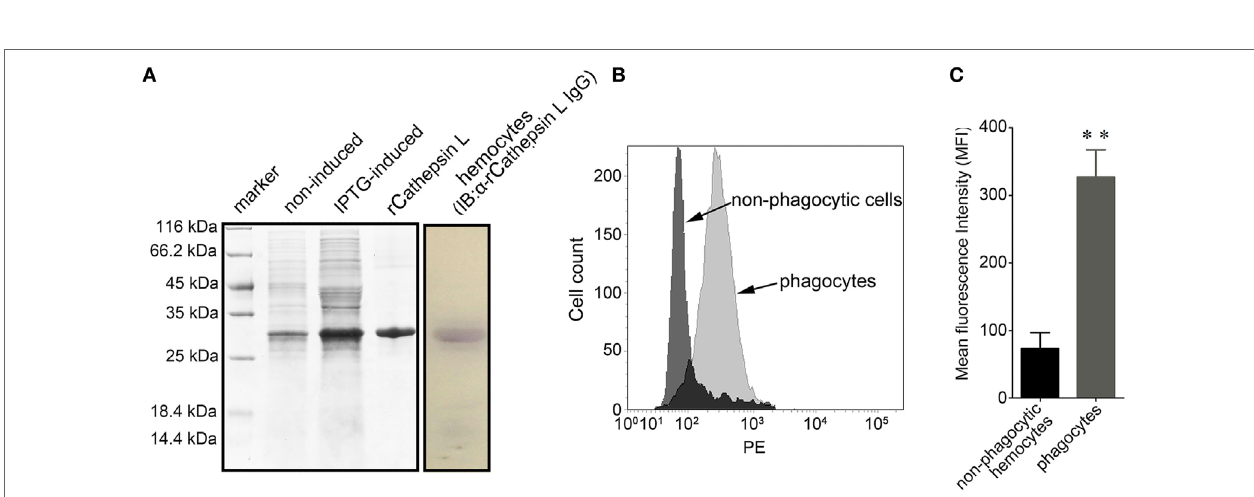
FigUre 8 | Differential expression of cathepsin L in hemocytes. (a) In this case, rCathepsin L was expressed and the purified form was separated using SDS-PAGE followed by Coomassie brilliant blue staining (left box). Western blotting analysis was then performed using polyclonal IgG against rCathepsin L (right box). IB: immunoblot. (B) Histogram to show the relative expression level of cathepsin L in phagocytes (gray) and non-phagocytic hemocytes (black) determined by flow cytometry. (c) The mean fluorescence intensity of cathepsin L was statistically calculated; these results are expressed as means ± SEM ( n = 5), ** p <